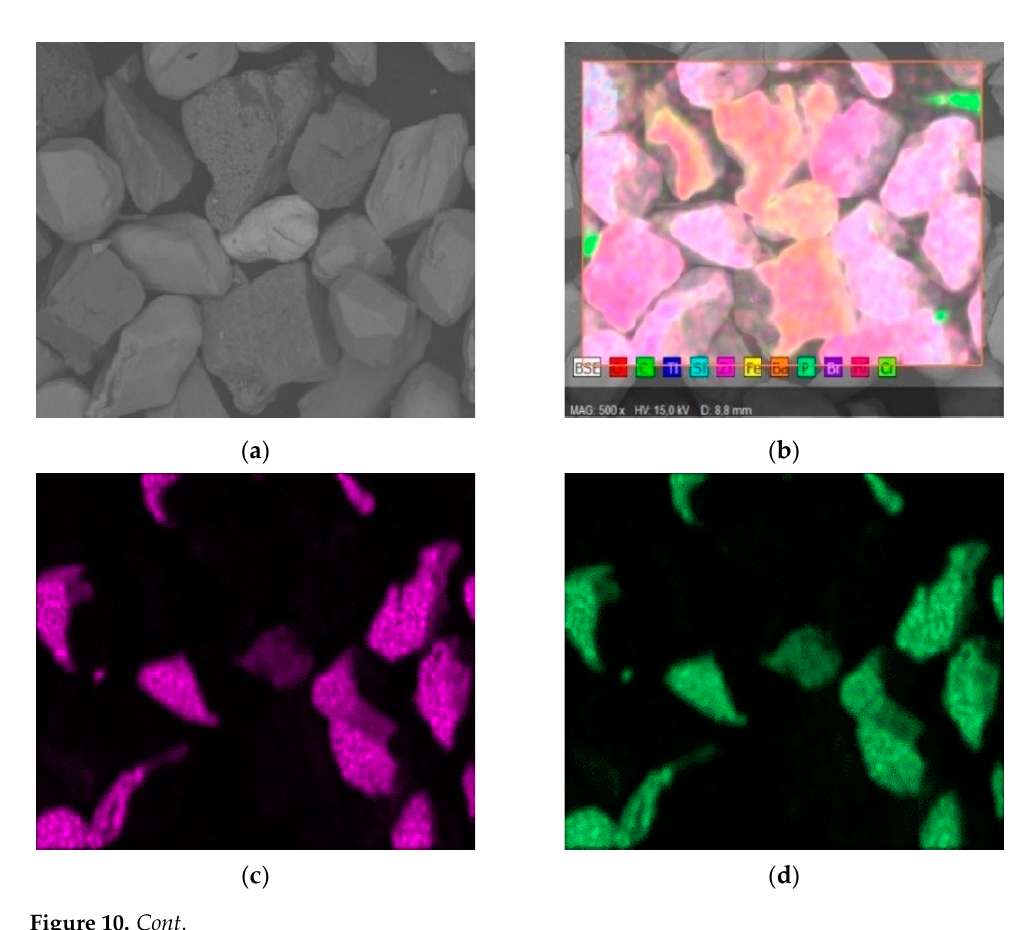
Figure 9. Particle size distribution.